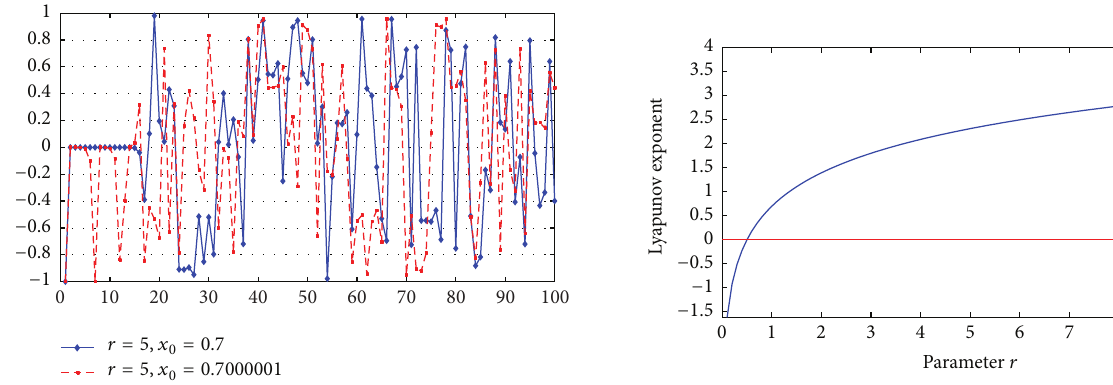
Figure 4: The Lyapunov exponent of the 𝑓 𝑟 map for 𝑟 ∈ [0, 10] .